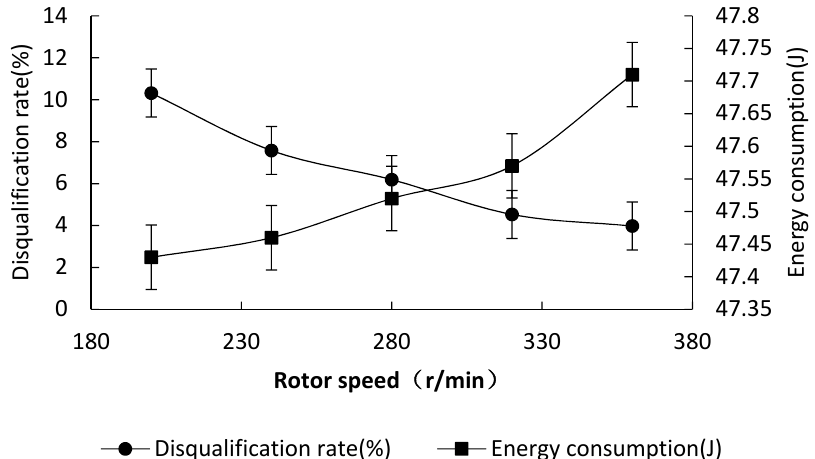
Figure 10. Experimental results of the influence of the cutter shaft rotor speed on the qualification rate and energy consumption of straw crushing.